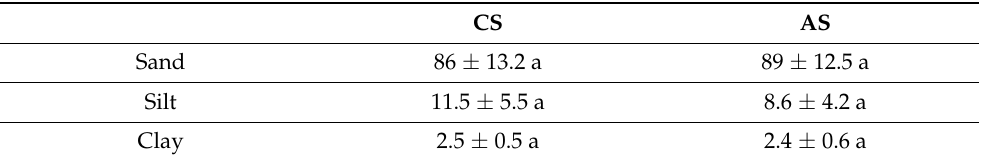
Table 2. Soil texture values expressed as percentage. CS: cultivated soils; AS: abandoned soils. Comparison between land uses; different letters indicate significant differences (Mann–Whitney U-test, p <